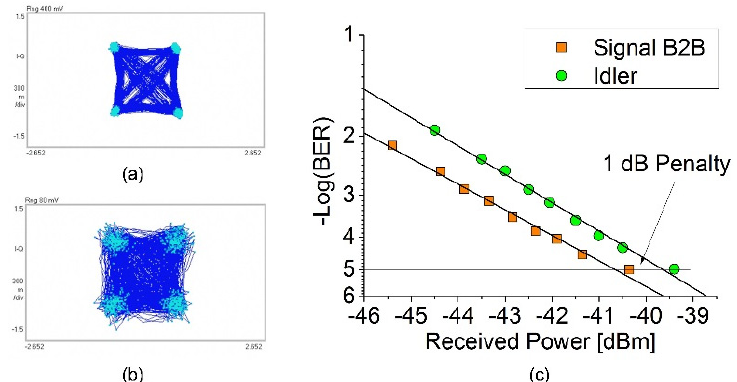
Figure 6. ( a ) QPSK (Quadrature Phase Shift Keying) B2B (back-to-back) and ( b ) converted constellation Figure 6 . ( a ) QPSK (Quadrature Phase Shift Keying) B2B (back ‐ to ‐ back) and ( b ) converted Figure 6 . ( a ) QPSK (Quadrature Phase Shift Keying) B2B (back ‐ to ‐ back) and ( b ) converted Figure 6 . ( a ) QPSK (Quadrature Phase Shift Keying) B2B (back ‐ to ‐ back) and ( b ) converted diagrams; ( c ) BER results constellation diagrams; ( c ) BER results [26]. constellation diagrams; ( c ) BER results [26]. constellation diagrams; ( c ) BER results [26].